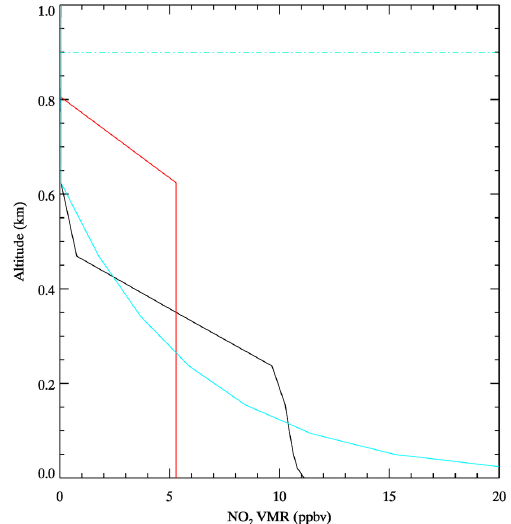
Figure 17. The constant (red) and exponential (blue) boundary layer NO 2 profiles used in the perturbation study. Above 2km the profile is the same as Fig. 9 (black). The dashed line represents the average flight altitude (900m).